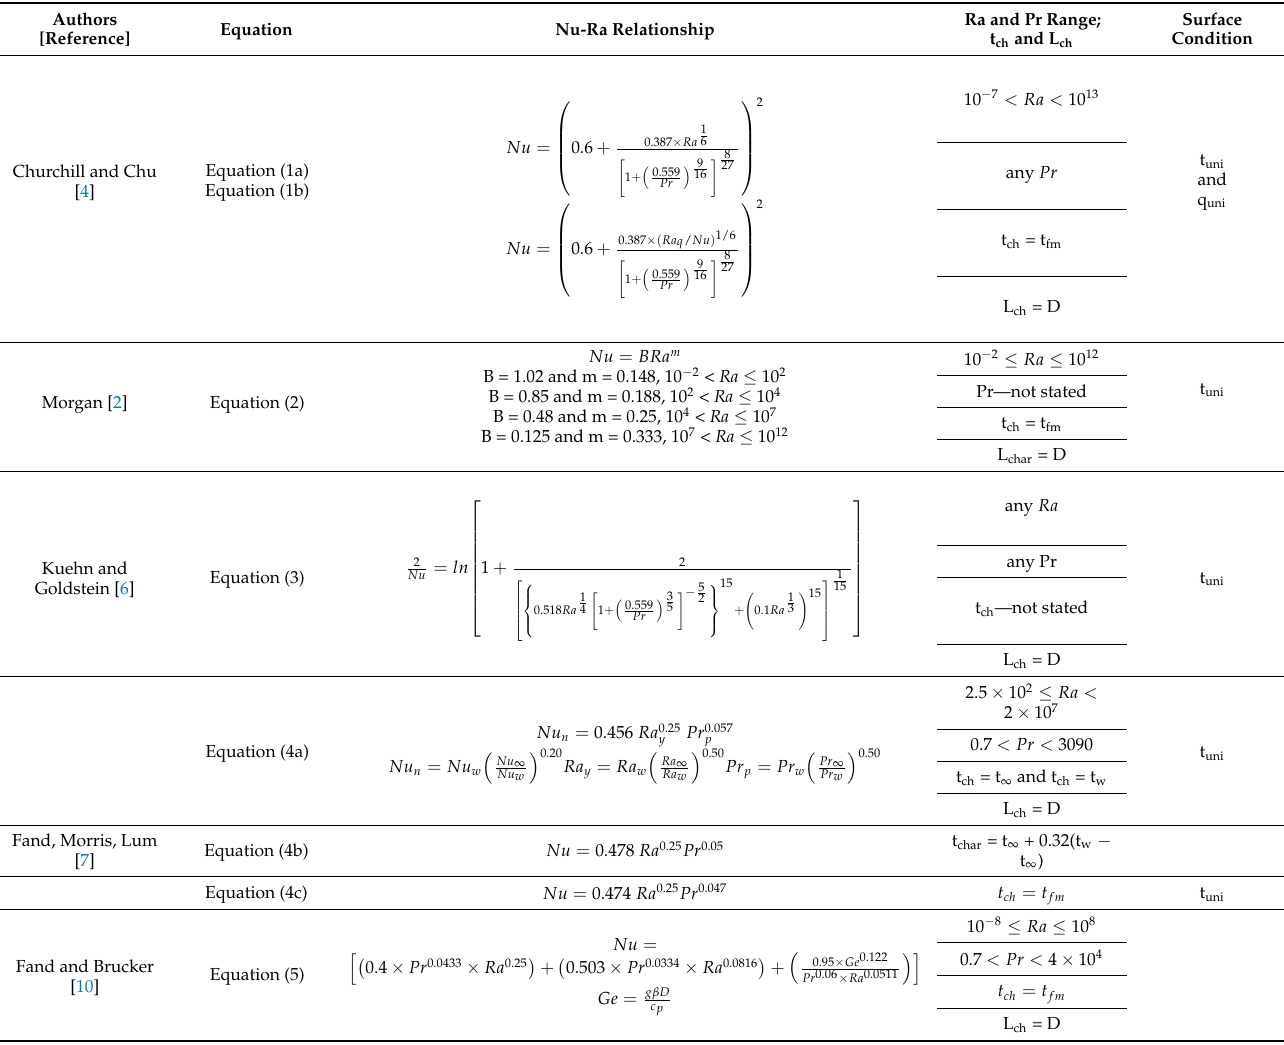
Table 1. Literature correlation